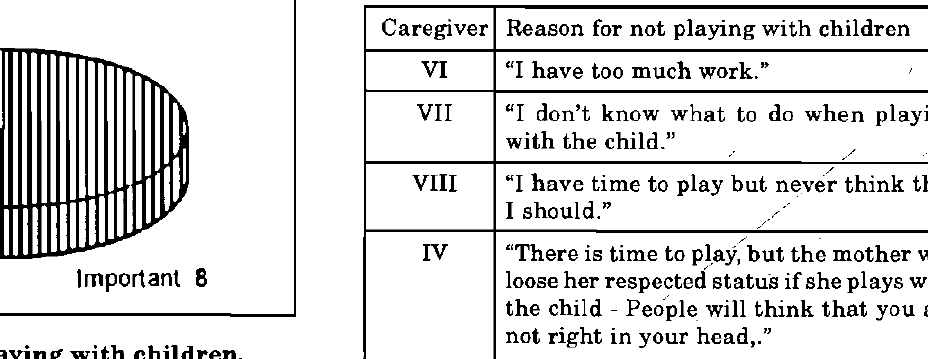
Figure 3. The value of playing with